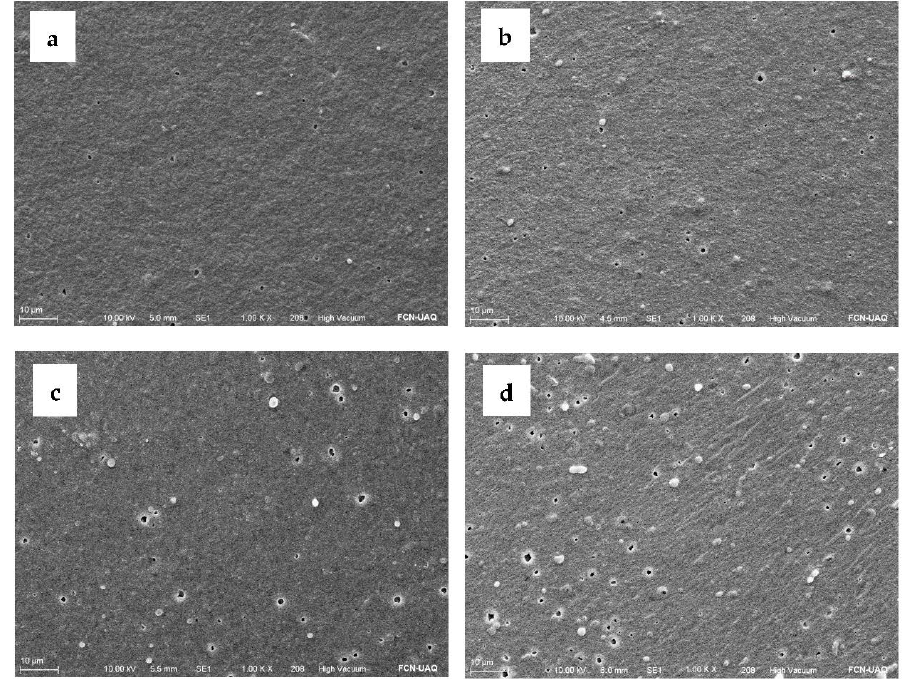
Figure 3. Scanning electron micrograph of active edible films (1000 × amplification). ( a ) 4:1 (amaranth protein isolate:chitosan, w / w ratio); ( b ) 9:1 (amaranth protein isolate:chitosan, w / w ratio); ( c ) 9:1 (amaranth protein isolate:chitosan, w / w ratio) + amino-functionalized mesoporous silica nanoparticles (A-MSN); ( d ) 9:1 (amaranth protein isolate:chitosan, w / w ratio) + mesoporous silica nanoparticles loaded with oregano essential oil (MSNO).